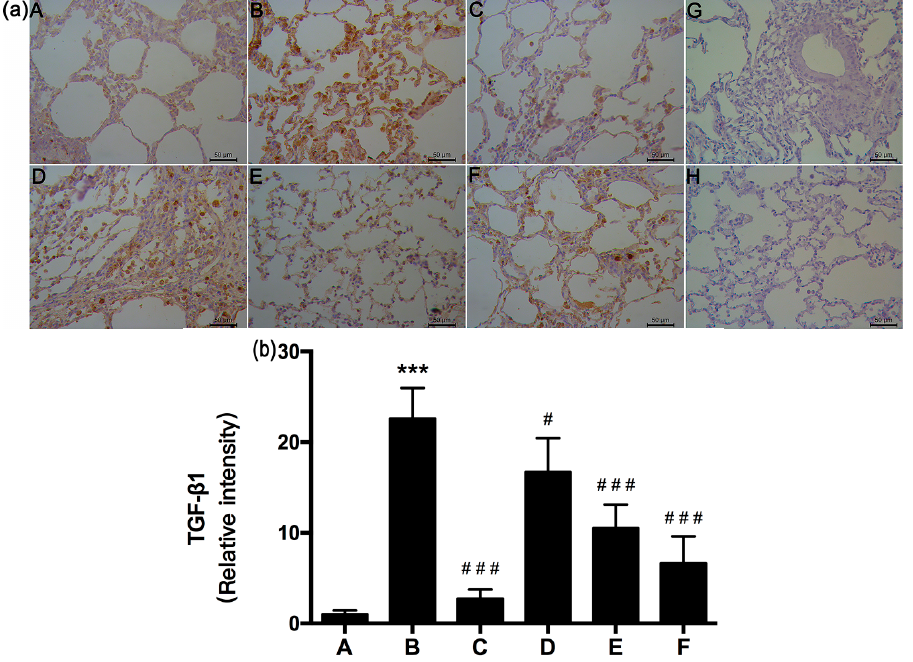
Figure 9. Effects of RRL on the levels of TGF- β 1 in the lung tissues after bleomycin (BLM)-induced in rats. ( a ) representative immunohistochemistry image (Bar = 50 µ m). ( A ) normal group; ( B ) model group; ( C ) PAG group; ( D – F ) are RRL groups treated with 125, 250 and 500 mg/kg,